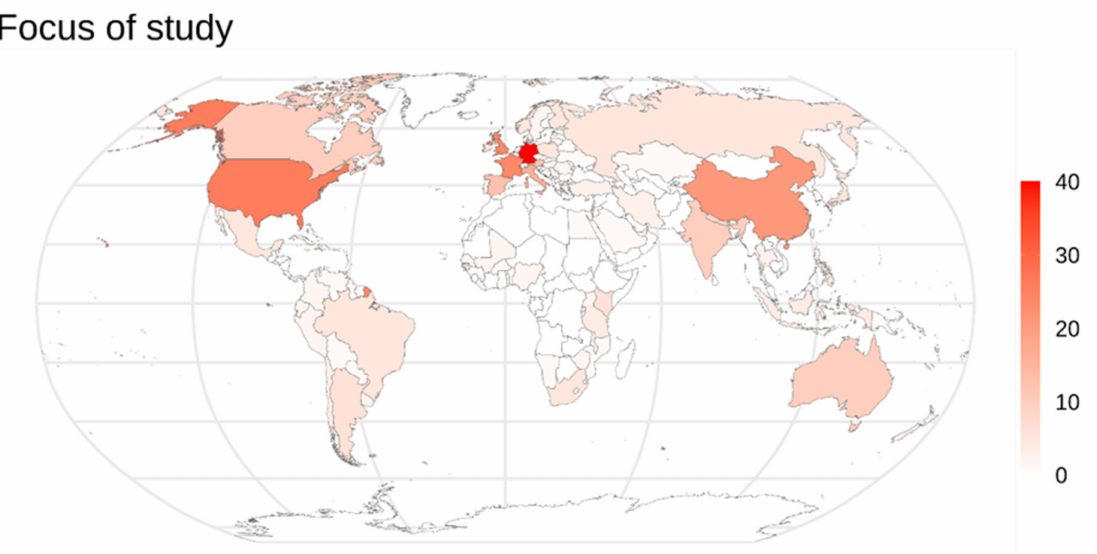
Figure 2. Country map based on the number of OSM-related papers with case studies in those